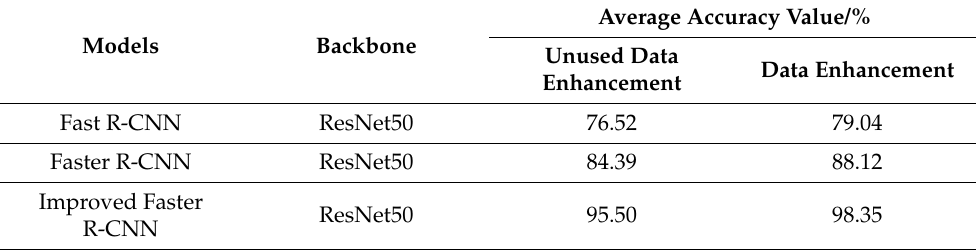
Table 2. Performance comparison of different